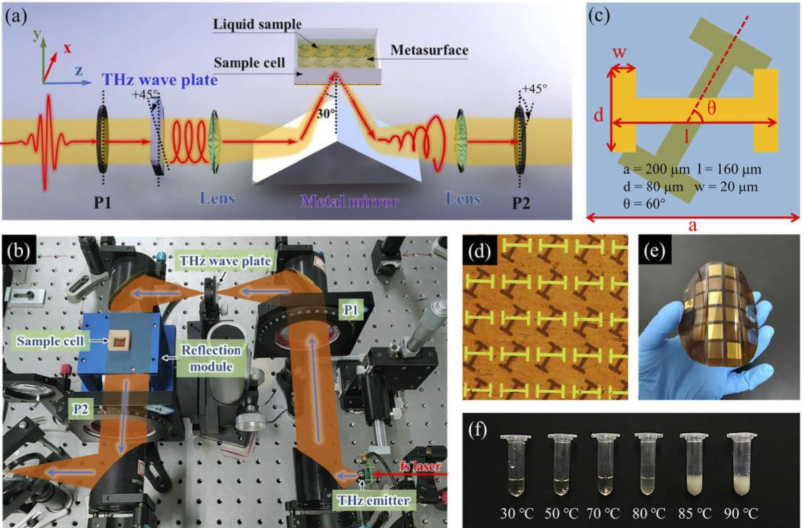
Figure 5. ( a ) Schematic diagram of the THz experimental configuration. ( b ) Photograph of the THz optical path of the experimental setup. ( c ) The geometry of the twisted dual-layer metasurface. ( d ) The micrograph of the metasurface. ( e ) Photograph of double-layer metasurface with the flexible PI substrate. ( f ) The appearance of BSA solution changes with temperature. Reprinted from Ref. [199].